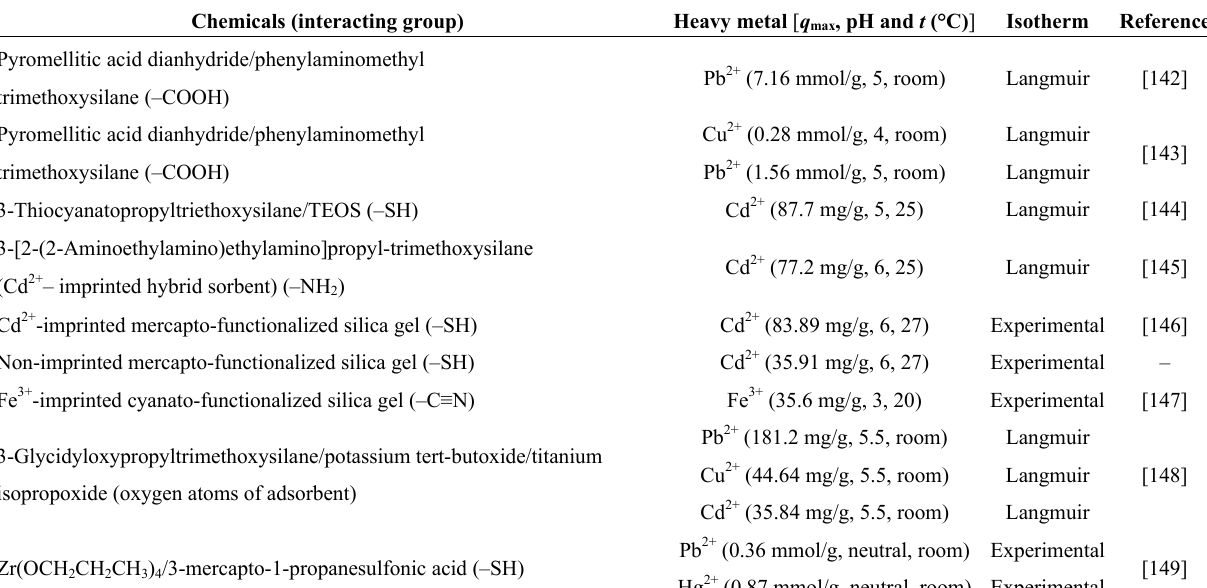
Table 1. Chemicals used for synthesizing adsorbents by sol-gel method, adsorbed heavy metals, maximum adsorption capacity, pH and temperature for adsorption of heavy metals from